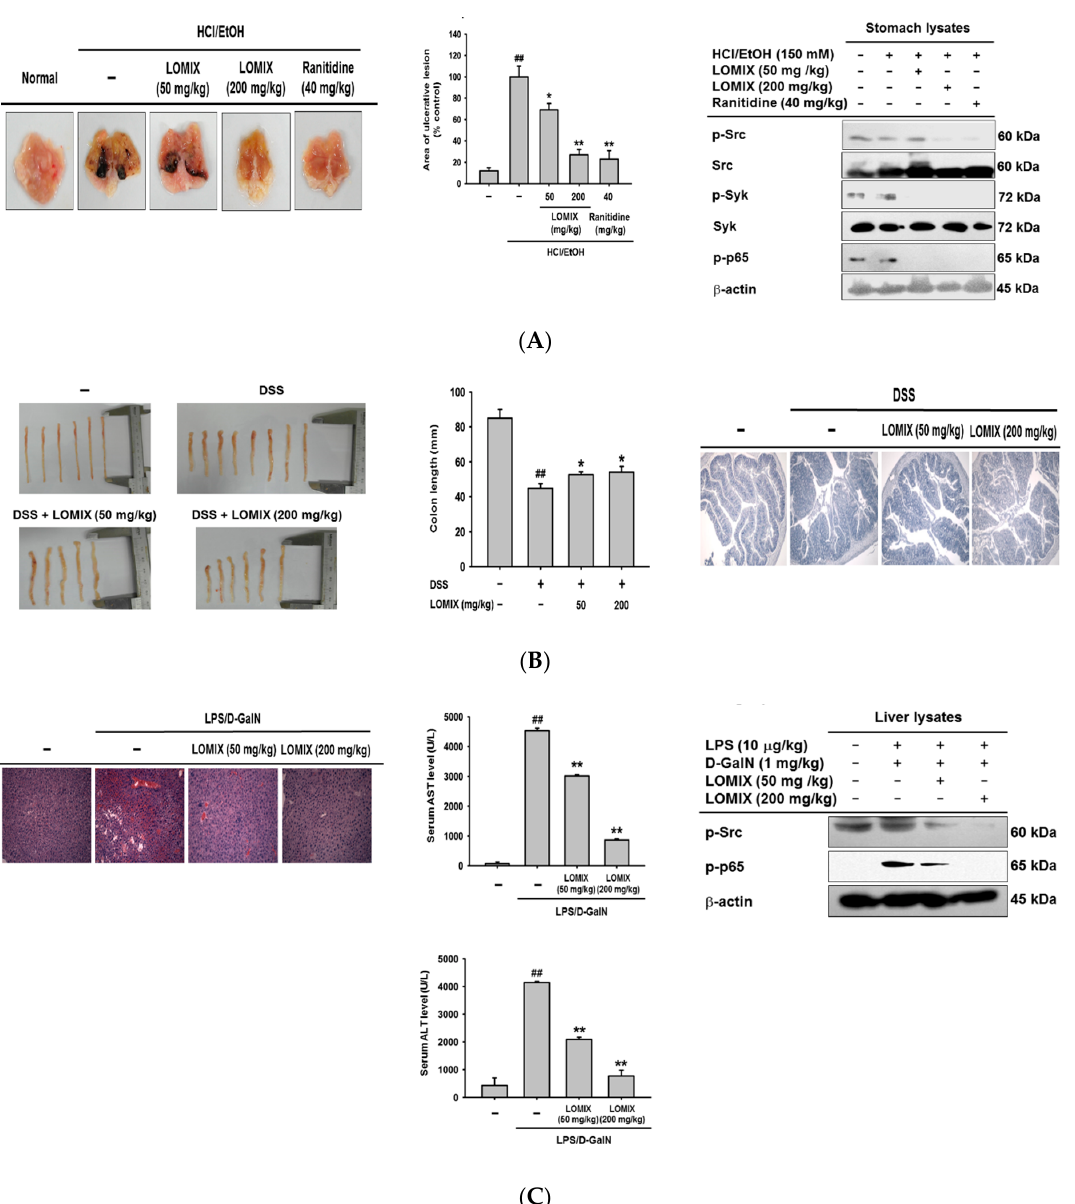
Figure 4. LOMIX ameliorates the symptoms of inflammatory diseases in mice. ( A ) ICR mice received the indicated doses of LOMIX or ranitidine (40 mg / kg) orally twice a day for 3 days. Thirty minutes after the final administration, experimental gastritis was induced by administering HCl / EtOH to the mice for 1 h. ( A left ) Ulcerative gastritis lesions were photographed, and ( A middle ) the areas of gastritis lesions were measured using ImageJ software and plotted. ( A right ) p-Src, Src, p-Syk, Syk, and p-p65 in whole stomach lysates were detected by Western blot analysis. ( B ) ICR mice received the indicated doses of LOMIX orally twice a day for 3 days. Thirty minutes after the final administration, experimental colitis was induced by administering 3% DSS (v / v) to the mice for 7 days. ( B left ) Colons were photographed, and ( B middle ) colon length was measured using calipers and plotted. ( B right